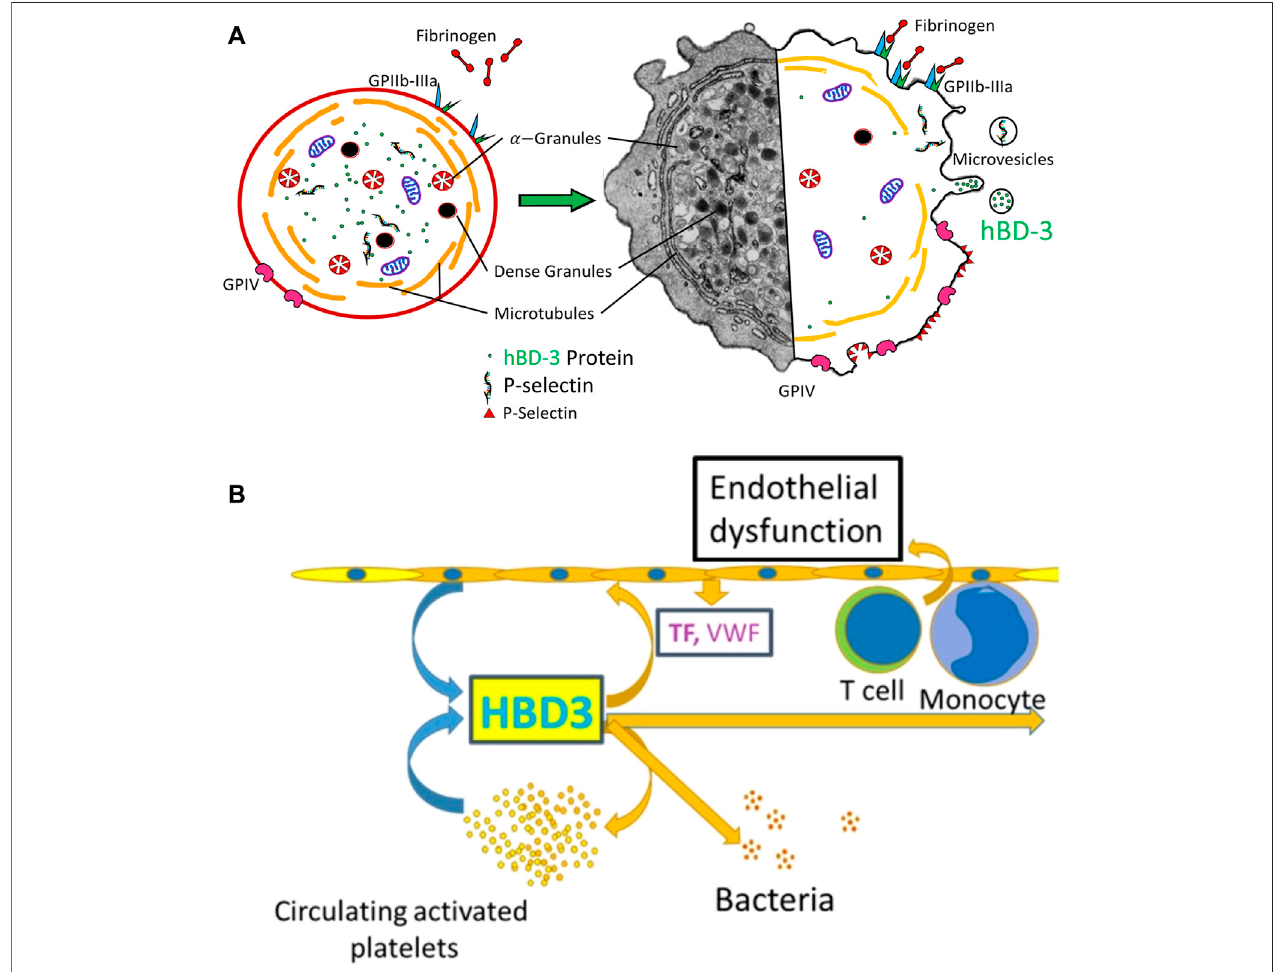
FIGURE 5 | (A) Hybrid-schematic diagram of resting and activated platelets showing relative expression of activation markers, de-granulation, and secretion of hBD-3 via microvesicles/exosomes. (B) Schematic diagram showing hBD-3 secreted from activated platelets in the exosomes is a potential contributor of continued endothelial dysfunction, platelet activation and a pro-thrombotic vascular